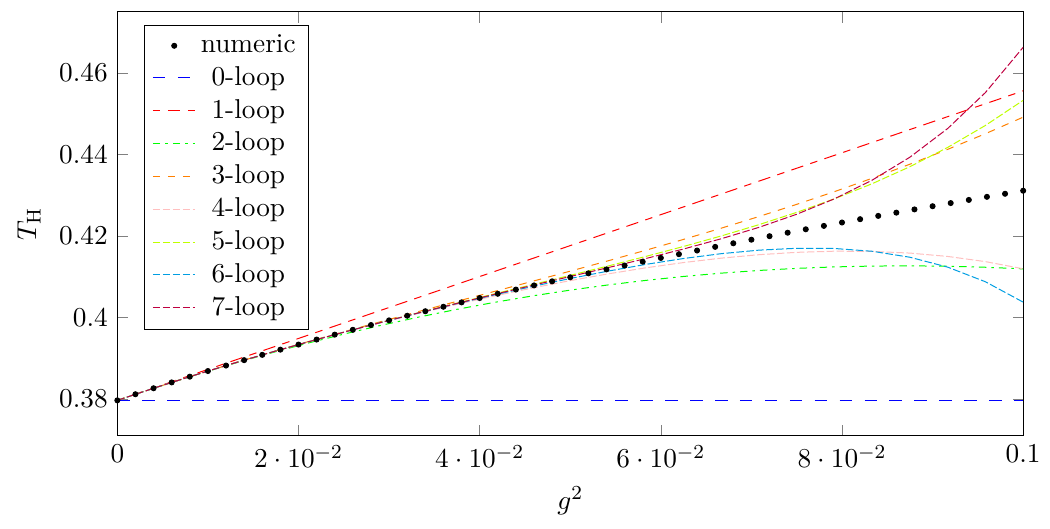
Figure 4. Numeric results and weak-coupling approximation at various loop orders for the Hagedorn temperature as a function of g 2 .